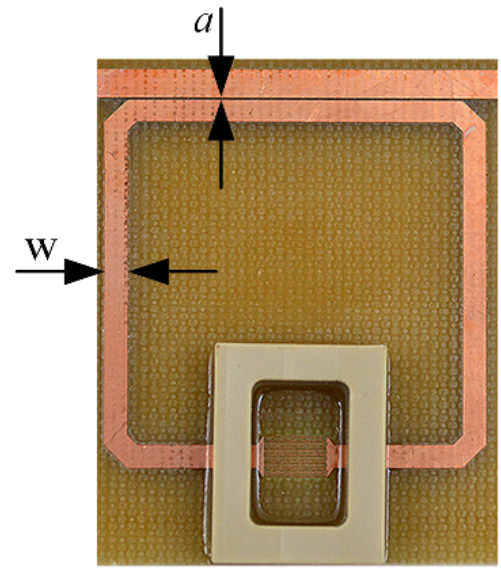
Figure 14. Split-ring resonator on a 1.4mm thick FR4 substrate with six-finger interdigital